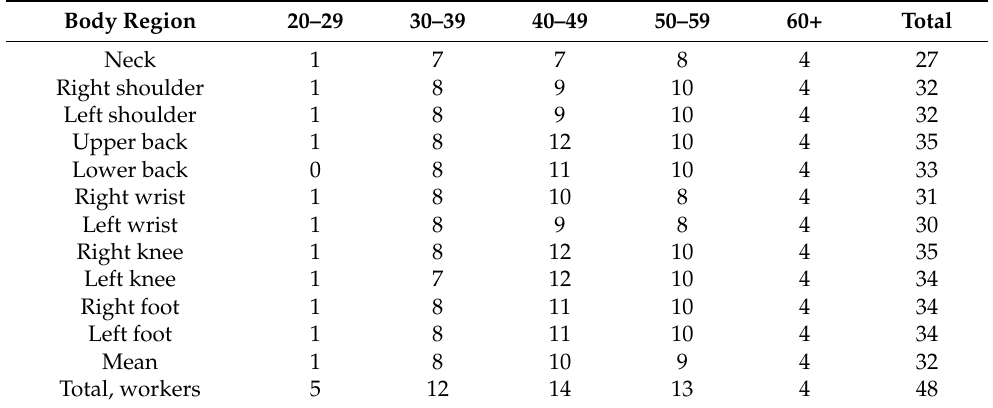
Table 7. Frequency (f) of workers by age range who perceived musculoskeletal symptoms by body region for more than 30 days and all days during the last 12 months.